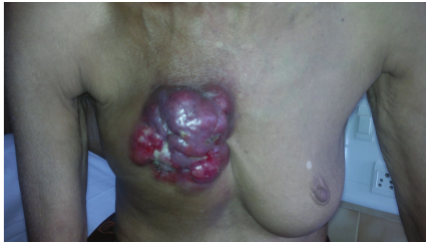
Figure 1: Photomicrograph of polypoid mass over the right breast. × 4 cm was noted in the right breast with loss of fat planes between lesion and right pectoralis muscle (Figure 2). Fine